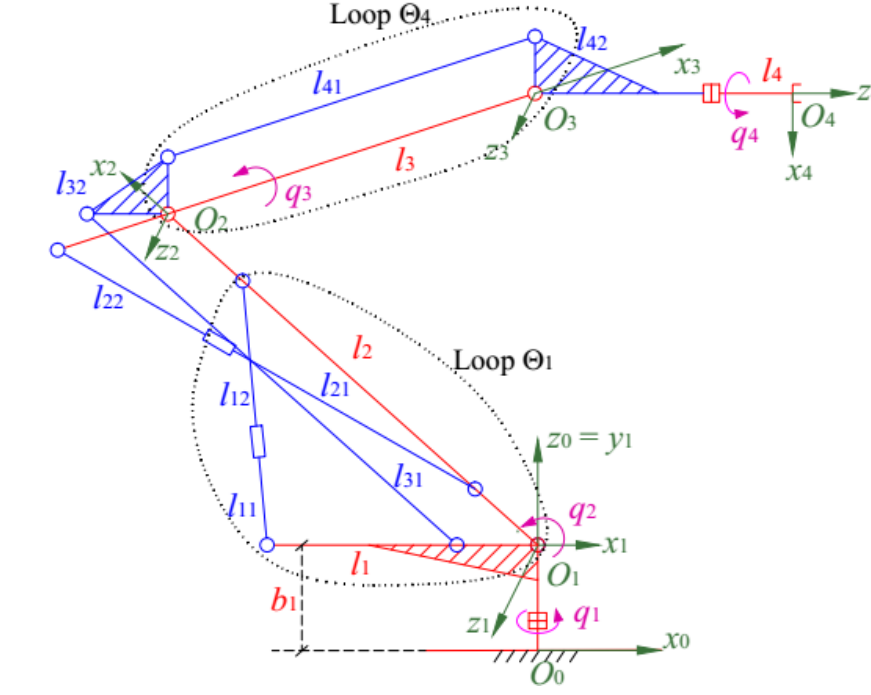
Figure 6. The kinematic chain of the forging robot.